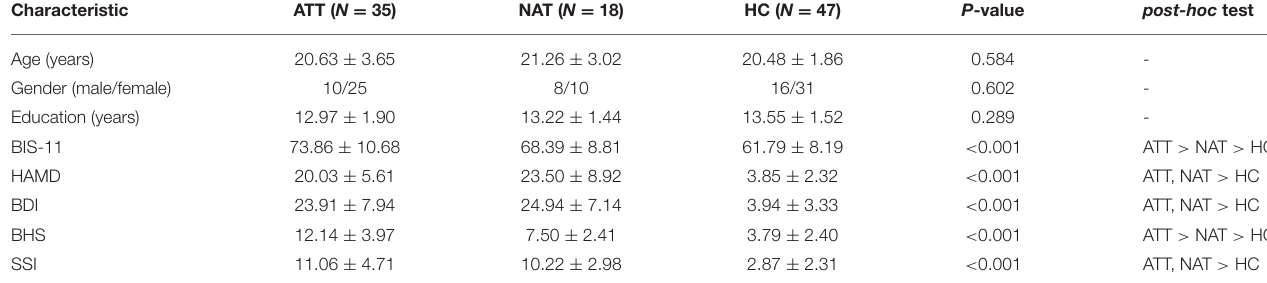
TABLE 1 | Demographic and clinical characteristics of patients and healthy. Characteristic